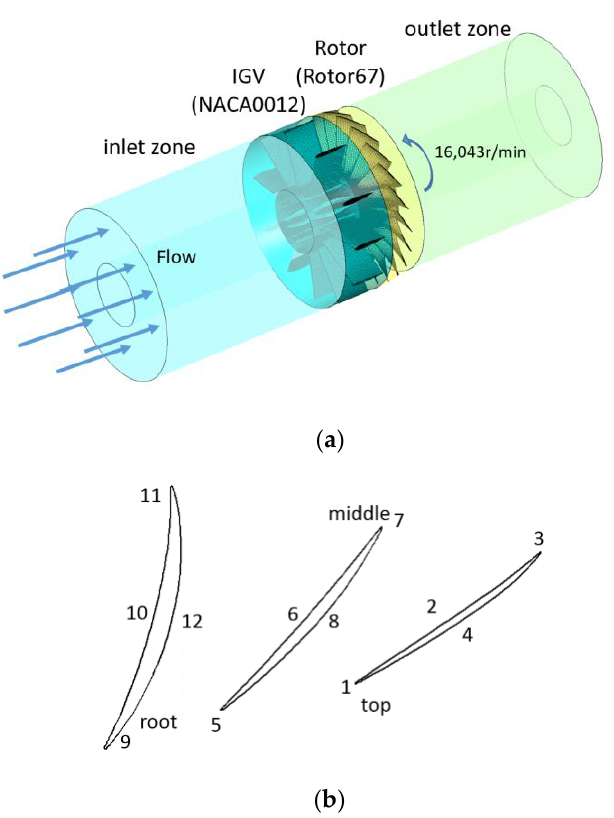
Figure 3. Description of ( a ) mesh of the fluid domain and ( b ) monitoring points on the rotor. Table 2. Results of the independent grid